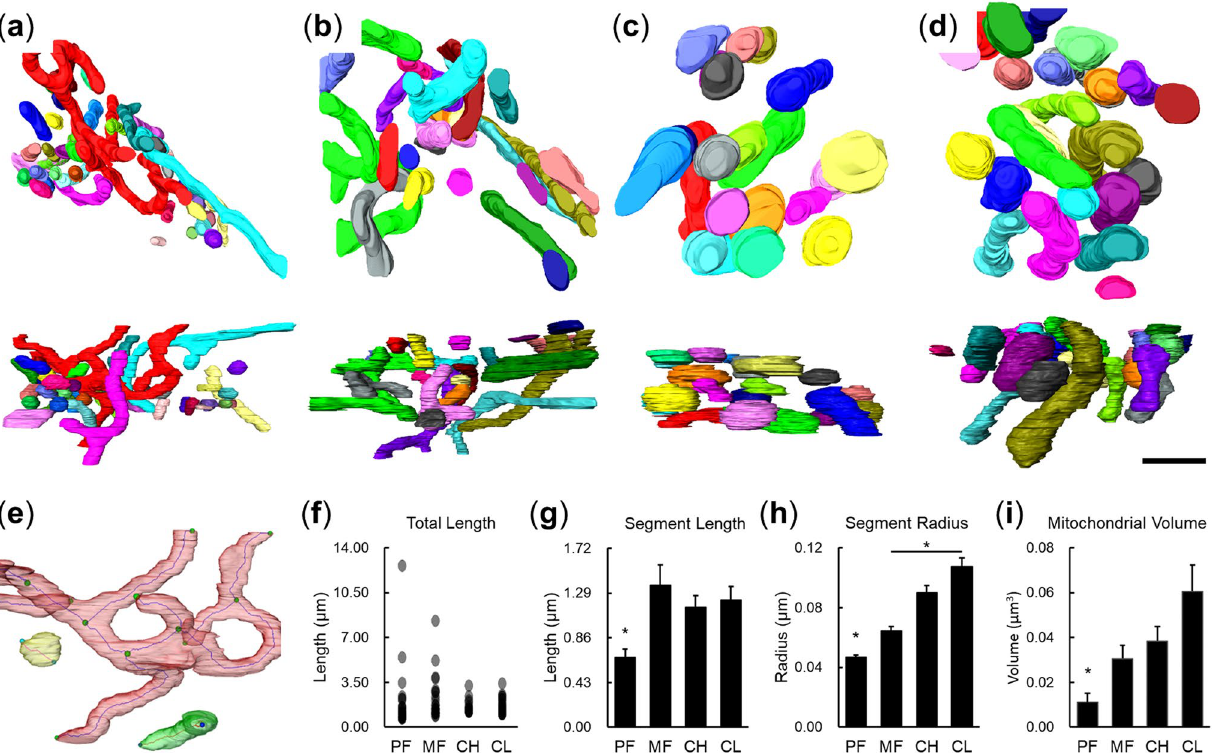
( b ), LLC in CH ( c ) and LLC in CL ( d ). Mitochondria without physical connections are labeled with different colors. Bar: 1 μm. ( e ) The diagram shows nodes (colored spheres) and central line segments (the line between two nodes) of mitochondria (labeled in transparent red color) in FC. ( f ) The distributions of total length of the central line segments in mitochondria from the LLC lineage. ( g , h ) The average of length ( g ) and mean radius ( h ) of the mitochondrial segments in the LLC lineage. ( i ) The average volumes of mitochondria in the LLC lineage. Data are presented as the mean ± SEM (n = 39 for PF, 22 for MF, 21 for CH, and 24 for CL). Statistical analysis was done with one-way ANOVA and Dunn’s multiple comparison test. * P <